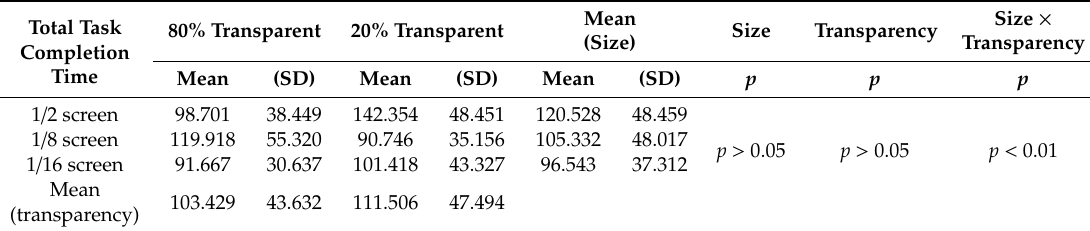
Table 3. Descriptive statistics and two-way ANOVA of total task completion time.